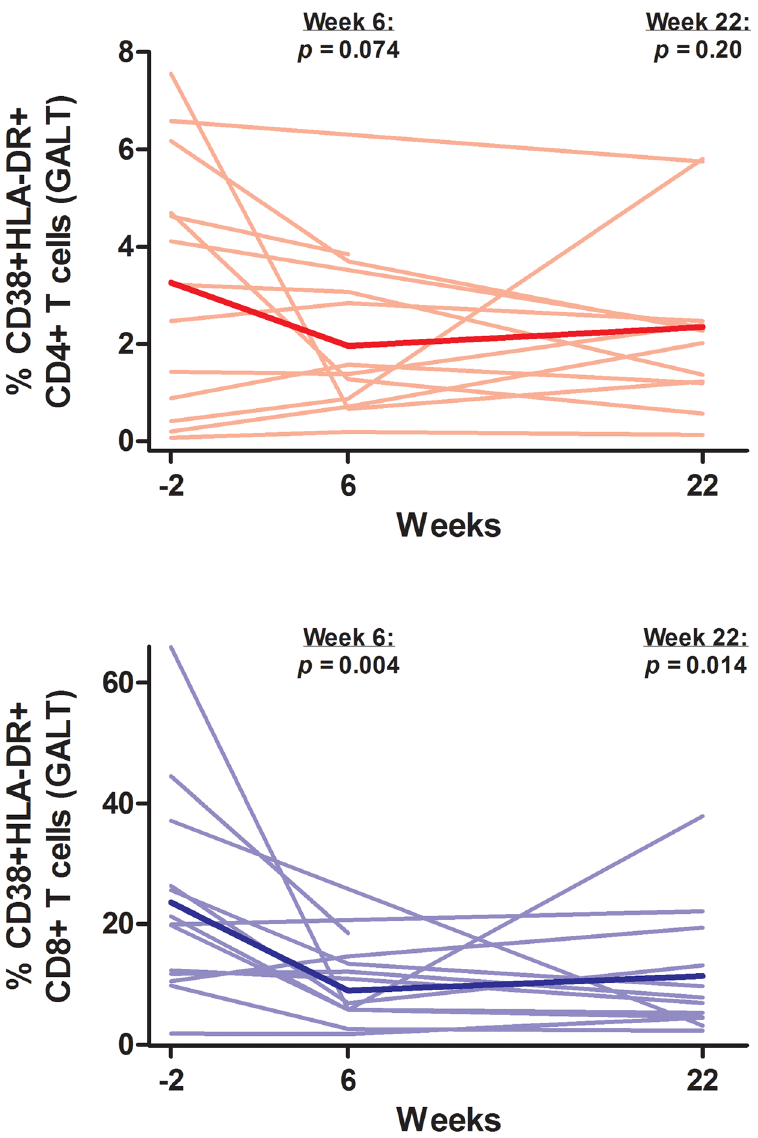
Figure 6. Change in T cell activation in rectum. Thin lines indicate data for each individual subject. The thick line indicates the estimated mean value over time from mixed effects linear regression. P-values refer to change from baseline at each referenced time-point. GALT=gut-associated lymphoid tissue. an Accuri C6 (BD Biosciences) with the Viacount assay (Millipore), and washed and stained the same day (T cell immunophenotyping) or rested overnight (cytokine flow cytometry [CFC]). The average viability of thawed cells was 93% (range 61–98%; 80% of samples had viability . 90%).